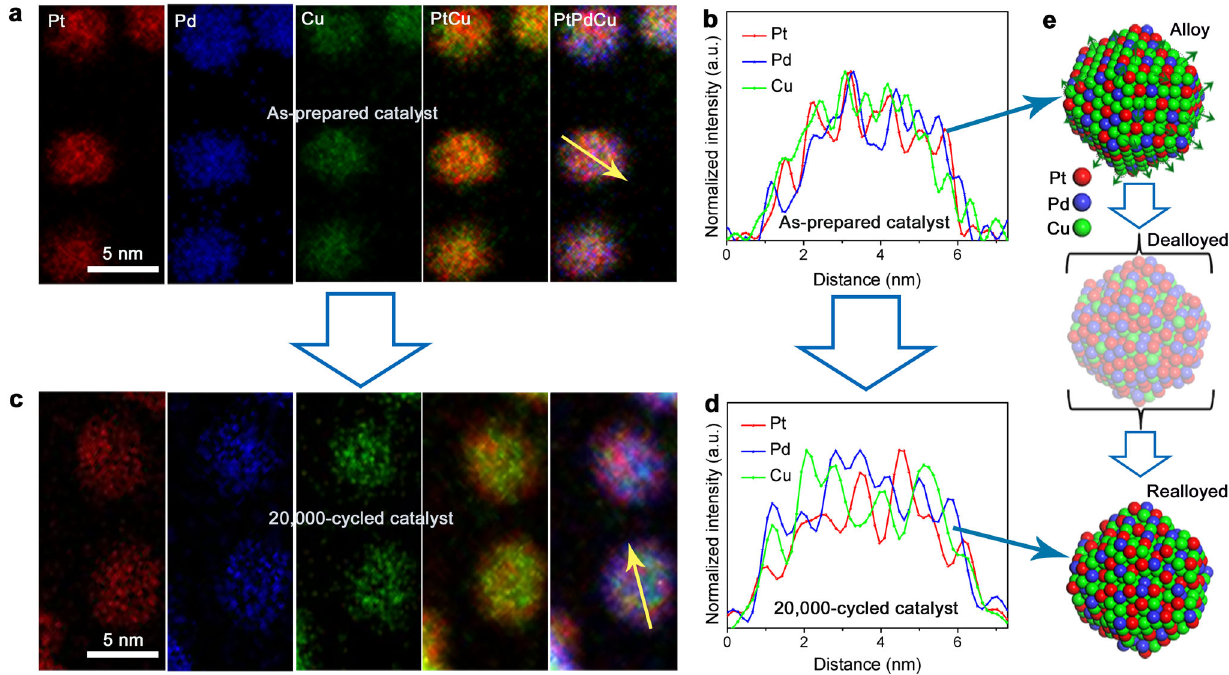
Fig. 3 Metal component distributions in Pt 20 Pd 20 Cu 60 /C catalyst before and after potential cycling. a , b STEM-EELS elemental mapping images and corresponding EELS line-scan pro fi les for the as-prepared (thermochemically calcined) catalyst. c , d STEM elemental mapping images and corresponding EELS line-scan pro fi les for the catalyst after 20,000 cycles (electrochemically cycled) by accelerated durability test in a standard electrochemical cell. The exact atomic compositions determined by energy-dispersive X-ray spectroscopy (EDS) are Pt 21 Pd 21 Cu 58 and Pt 27 Pd 27 Cu 46 for the as-prepared and the 20,000-cycled Pt 20 Pd 20 Cu 60 /C, respectively. e Illustration of the metal component distribution of the ternary NP before (Alloy) and after (Realloyed) potential cycling based on the results shown in b and d . The intermediate “ Dealloyed ” NP is also included for